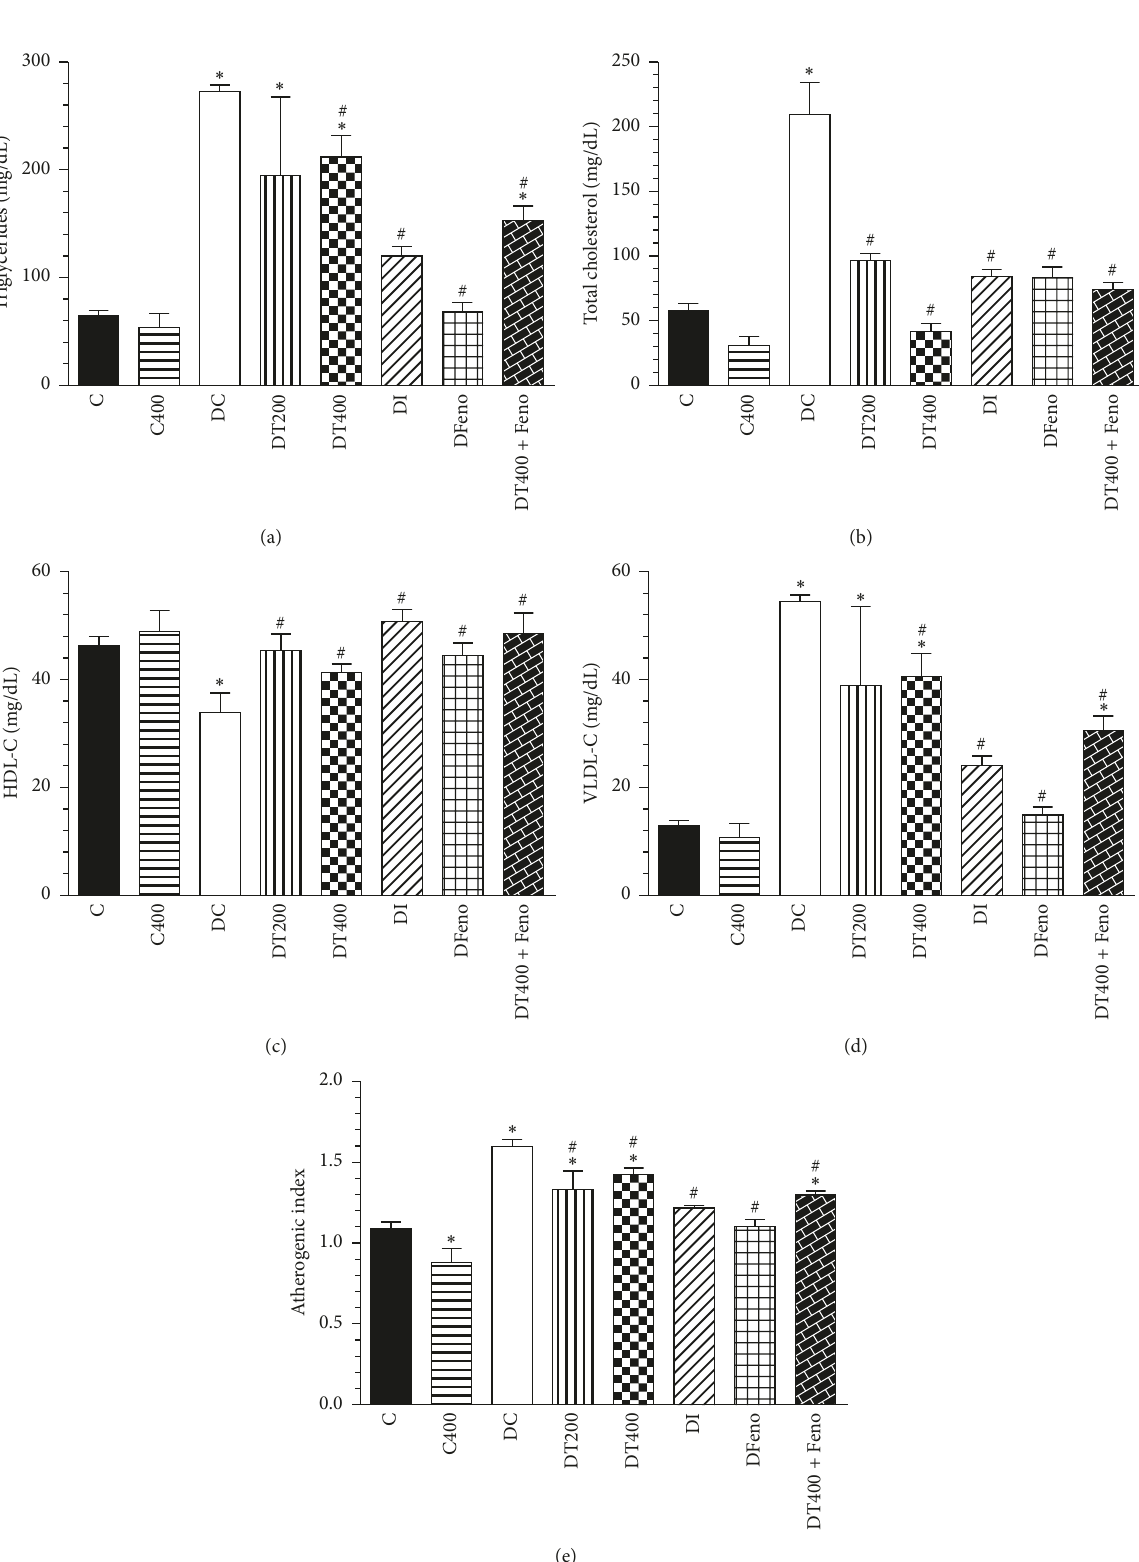
Figure 4: Effects of the EEMn on lipid profile and atherogenic index after 14 days of experiment. C, nondiabetic control; CT400, nondiabetic control rats treated with 400 mg/Kg of EEMn; DC, diabetic control; DT200, diabetic rats treated with 200 mg/Kg of EEMn; DT400, diabetic rats treated with 400 mg/Kg of EEMn; DI, diabetic rat treated with insulin (3 U/rat); DFeno, diabetic rat treated with fenofibrate (150mg/Kg). Each point represents the means ± SEM of 6–8 animals. ∗ 𝑃 < 0.05 versus C; # 𝑃 < 0.05 versus